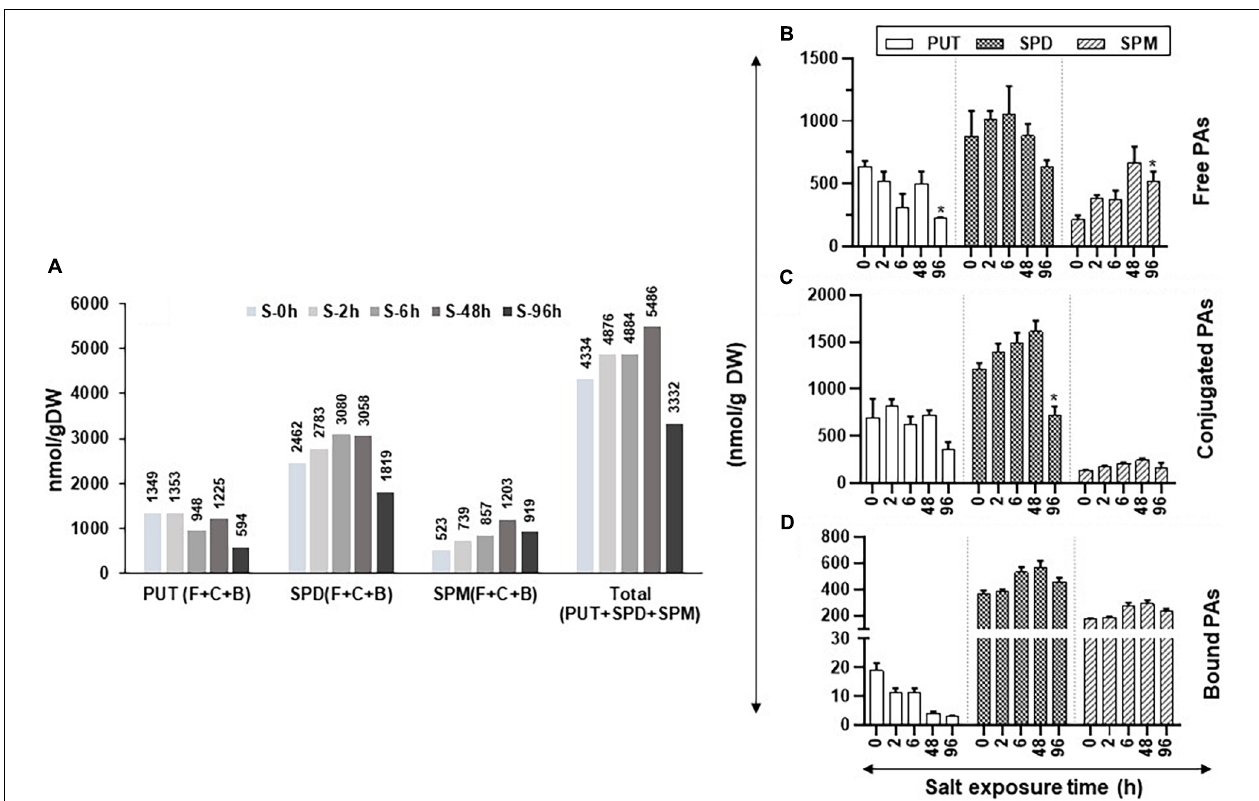
FIGURE 5 | Changes in the levels of free, conjugated, and bound forms of PUT, SPD, and SPM in tomato leaves during salt stress. Salt stress was imposed on tomato plants by irrigating plants daily with 200-mM NaCl (salt stress). Leaf samples from a minimum of three plants were harvested at 0, 2, 6, 48, and 96 h and immediately frozen in liquid N 2 and then stored at –80 ◦ C until analyzed. HPLC was used to determine the levels of free, bound, and conjugated forms of PAs. (A) Changes in the total amount of free, bound, and conjugated forms of PUT, SPD, and SPM; (B) free PUT, SPD, and SPM; (C) conjugated PUT, SPD, and SPM; (D) bound PUT, SPD, and SPM, respectively, during salt stress, respectively. Other details were the same as in Figure 1